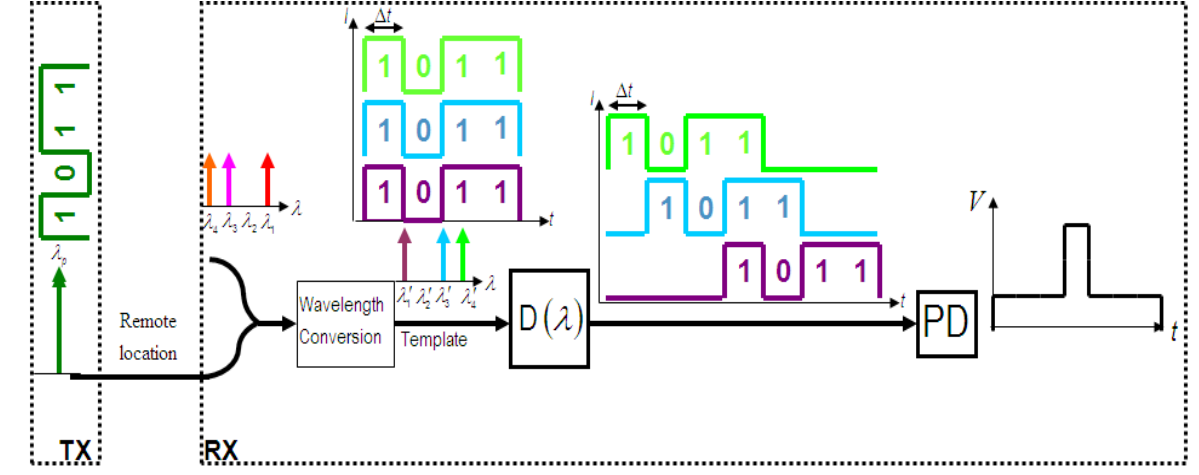
Figure 3 . Illustration of the working principle of the proposed HNLF based correlation